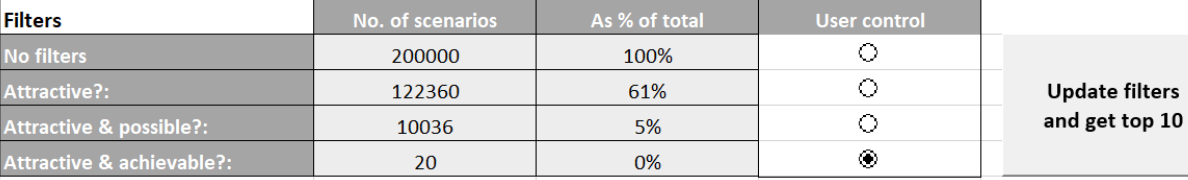
Figure 8. Screenshot showing the filters which can be applied to the outputs of the scenario creation tool: No filters, Attractive filter, Attractive & Possible filter, and Attractive & Achievable filter.